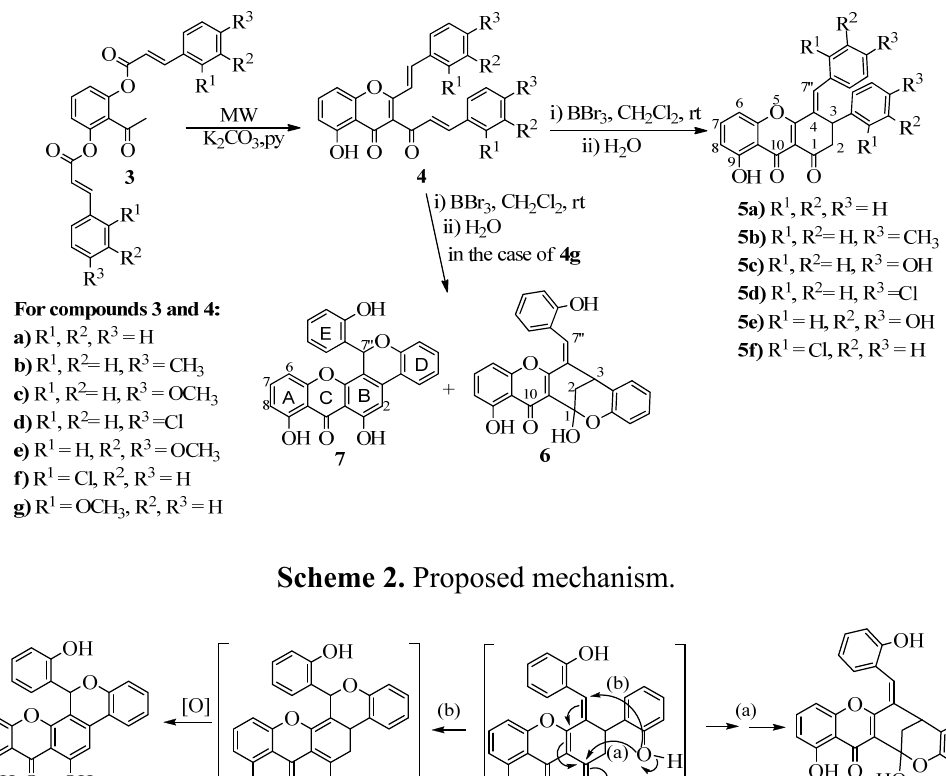
Scheme 1. Synthesis of xanthene-1,9(2 H )-diones.